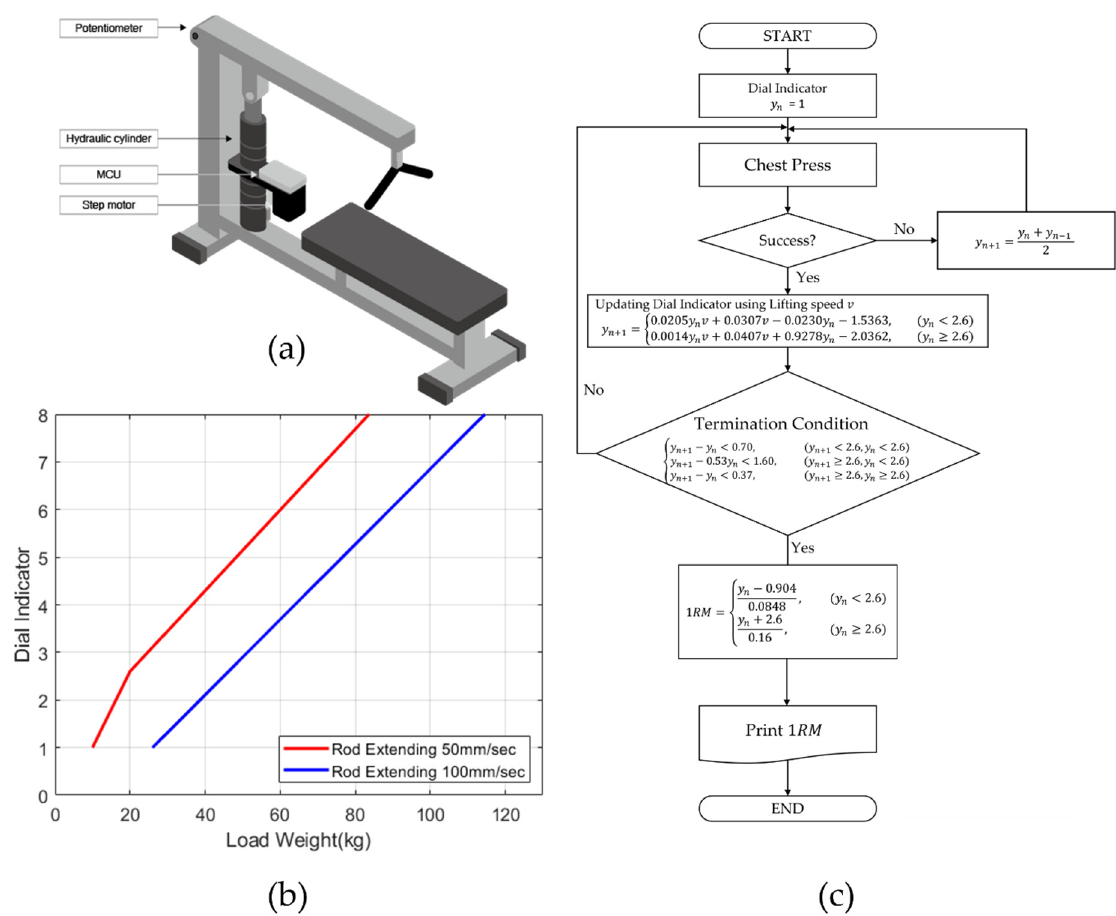
Figure 1. ( a ) A hydraulic cylinder and a step motor were connected to a conventional bench press machine. Instead of weight plates, hydraulic pressure from the cylinder acted as load weight to the machine; ( b ) As the dial indicator increases, the load weight almost linearly increases. The extending speed of the cylinder rod affects the load weight as well; ( c ) The flow chart summarizes the 1RM measurement process using the hydraulic press machine.